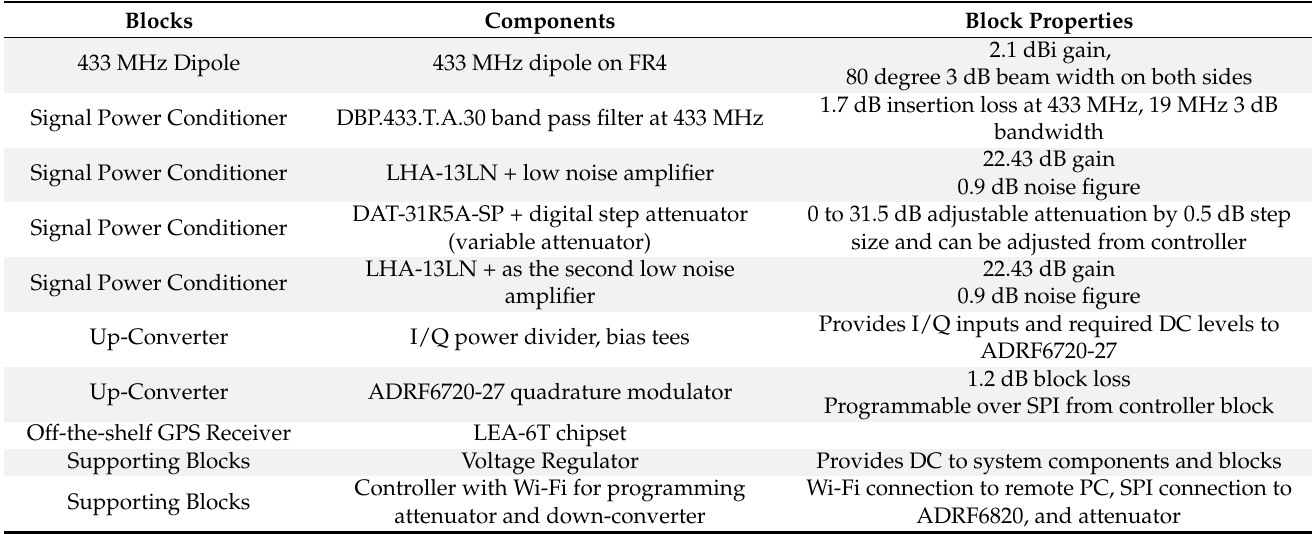
Table 2. Receiver subsystem and its components.